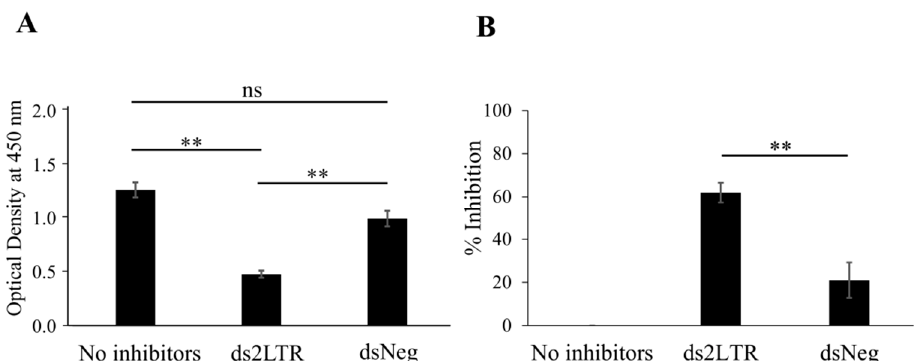
Figure 2. Competitive ELISA analysis for the specific binding of 2LTRZFP-GFP to ds2LTR DNA target. ( A ) The competitive reactions were reviewed by HRP-conjugated anti-His tag and measured optical density (OD) at 450 nm and ( B ) the signals obtained was converted into % inhibition. Data presented are from triplicate experiments (mean ± SD), analyzed using paired Student’s t -test. Statistical significance was evaluated at ** p ≤ 0.01, ns > 0.05 .